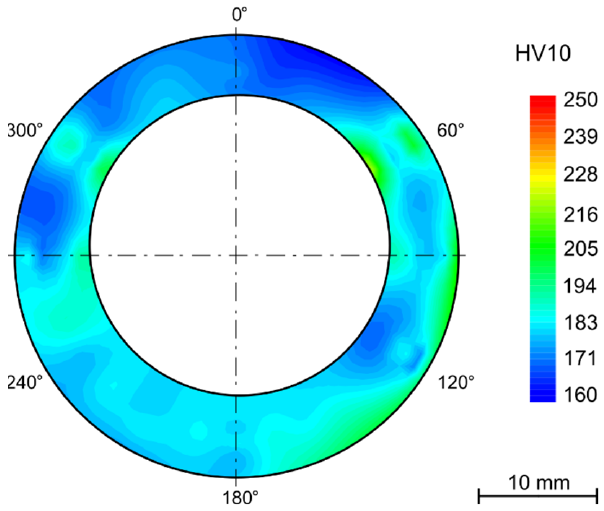
Figure 6. Solution annealed after bending (1,130 °C/15 min/water). After bending and in some cases after annealing, the samples were thermally aged for 7500 h in the laboratory furnace at 650 ◦ C. Among the annealed samples, this even led to a decrease in hardness to 202 ± 3 HV10. In the case of samples that were thermally aged but were not annealed after bending, the average hardness decreased from 299 ± 22 HV10 to 265 ± 18HV10. With the absence of the annealing process, the difference in the hardness values across the tube wall remained. The same pattern can be observed in the hardness maps of the samples exposed to the operating conditions (Figure